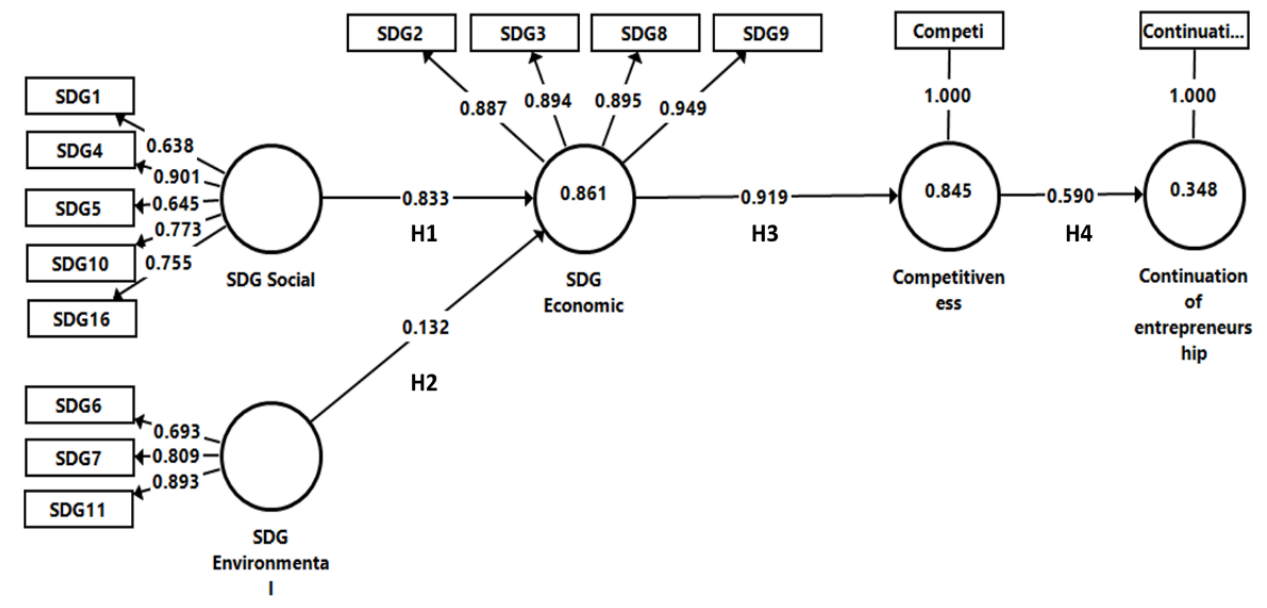
Figure 2. Proposed Research Model Tested.